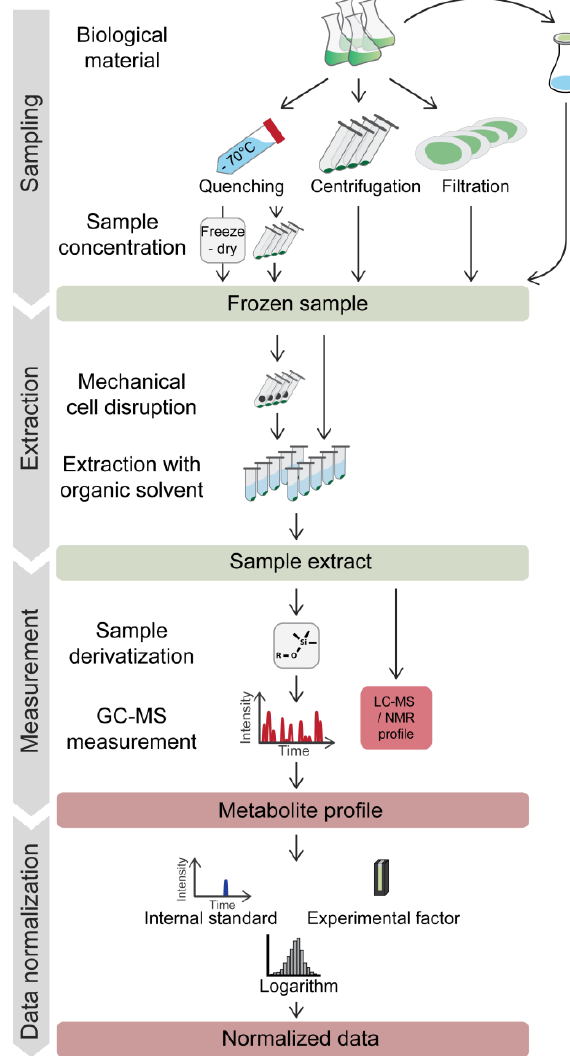
Figure 1. Typical workflow for metabolic profiling experiments on microorganisms. Harvesting of microbes for metabolite profiling may involve a rapid quenching step. Frozen samples are extracted with organic solvents, optionally including a grinding step. For GC-MS analysis, extracts have to be chemically derivatized to enhance the thermal stability and volatility of the compounds. Most frequently, the first standardization steps involve normalization to labeled internal standard(s) and to a reference value for the analyzed biomass (e.g. culture optical density (OD)) for the comparison of data from different samples. Logarithmic transformation is commonly utilized to achieve a near normal distribution of the data. For further descriptions, see the